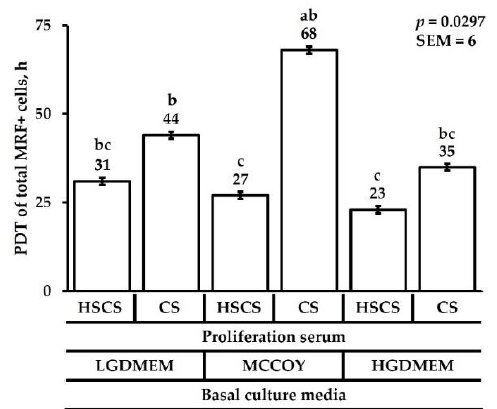
Figure 4. The effect of basal culture media and proliferation sera on population doubling time of total MRF+ cells expressed in h. Cells were cultured in either low glucose Dulbecco’s Modified Eagles medium (LGDMEM), McCoy’s 5A (MCCOY), or high glucose Dulbecco’s Modified Eagles medium (HGDMEM) supplemented with either 5% horse serum + 10% chicken serum (HSCS) or 15% chicken serum (CS). a – c Means with different superscripts describe a difference p < 0.05 and were generated from the pairwise mean comparison analysis.